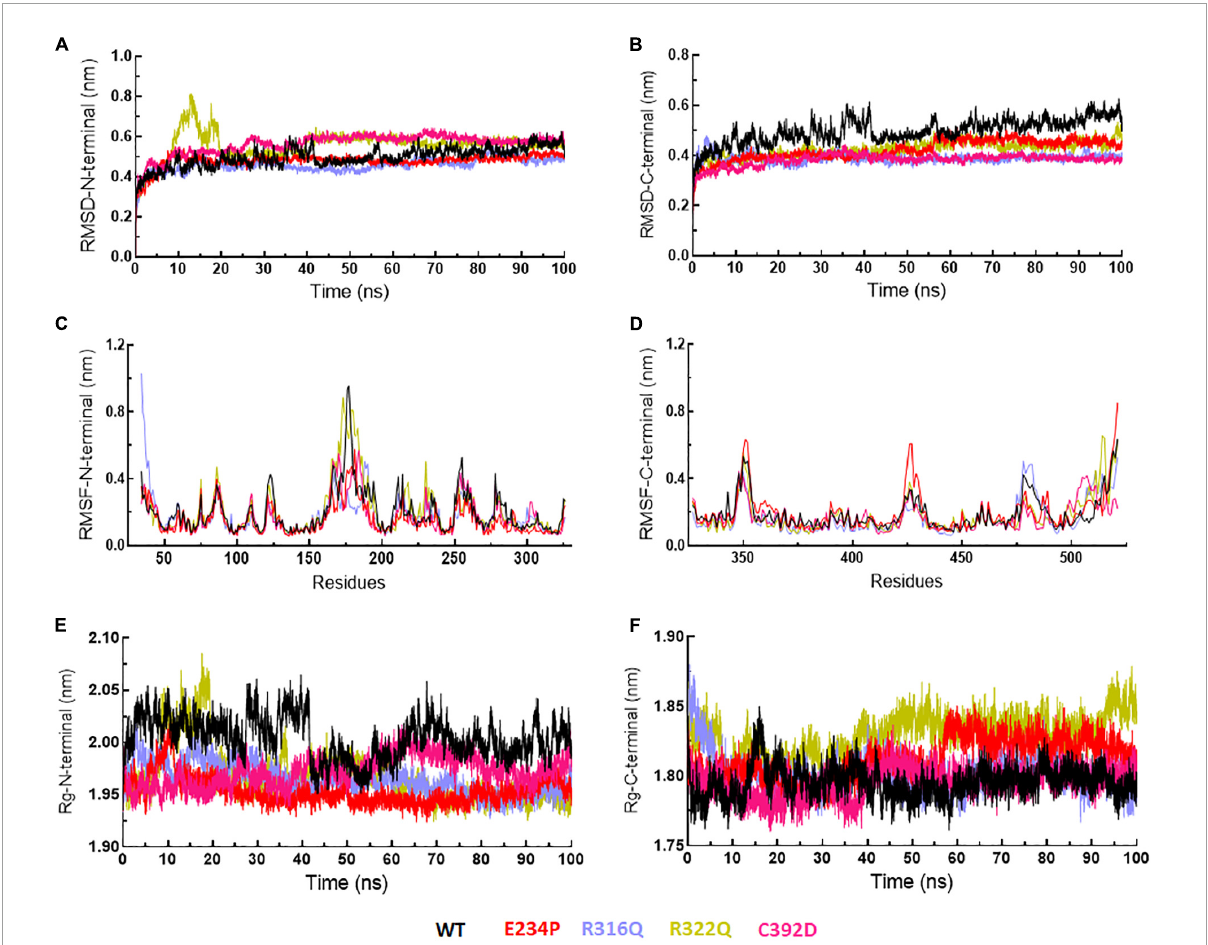
FIGURE6 MD simulation profiles of N- and C-terminal domains of WT and MT proteins. (A,B) RMSD profiles of N- and C-terminal domains, (C,D) RMSF profiles of N- and C-terminal domains, and (E,F) radius of gyration plots of N- and C-terminal domains. WT, E234P, R316Q, R322Q, and C392D were labeled in black, red, blue, mustard, and magenta color,